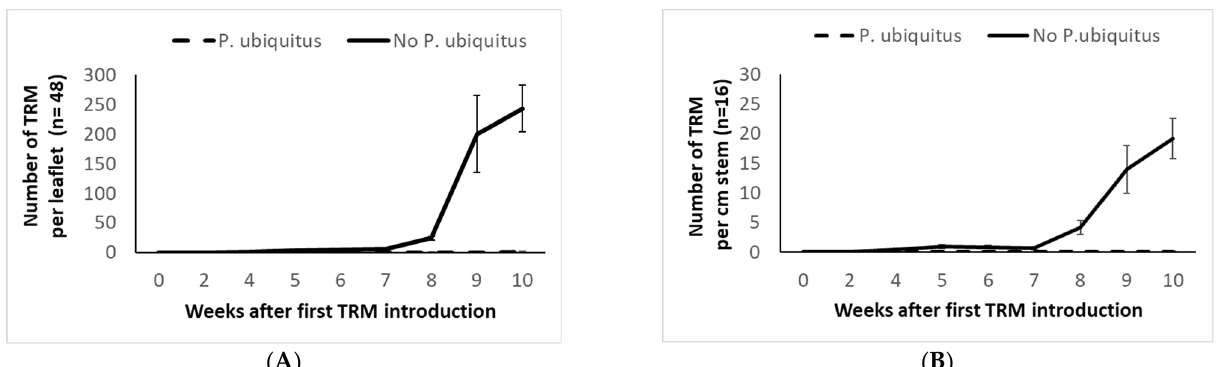
Figure 7. Population dynamics of TRM (mean number of mobile mites ± SE) found on the leaflets ( A ) and on the stem ( B ) nearby the point of the artificial infestation in an experimental greenhouse tomato crop.